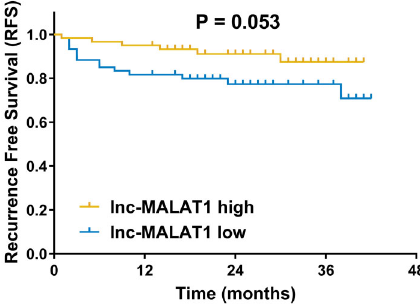
Figure 5. Kaplan-Meier curves show the recurrence-free survival in lnc-MALAT1 high expression and lnc-MALAT1 low expression patients determined by the log-rank test. lnc-MALAT1: long non- coding RNA metastasis-associated lung adenocarcinoma tran- script